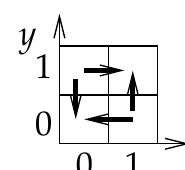
parameters to be identified. ( Right ): a sensible global behavior, associated with the parameter values: to be identified. Right: a sensible global behaviour, associated with the parameter values: K x = 0,